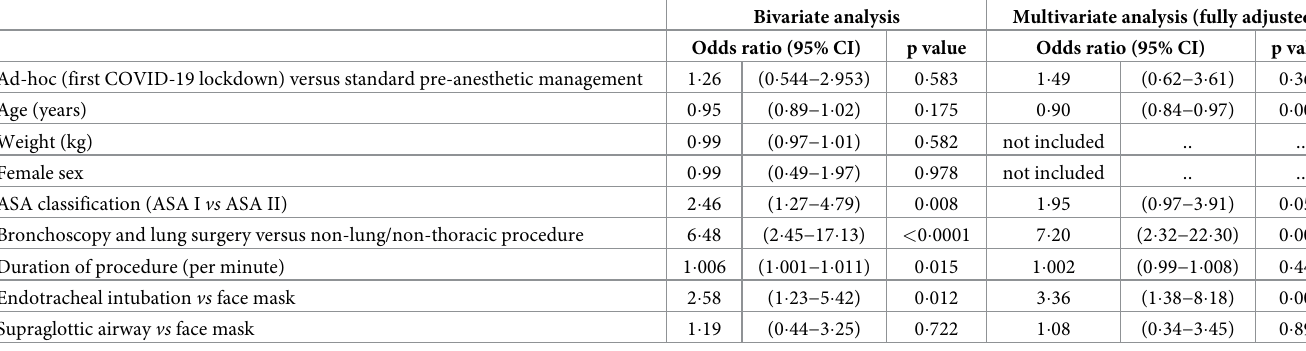
Table 6. Logistic regression analysis for peripheral oxygen saturation (SpO 2 ) drops <